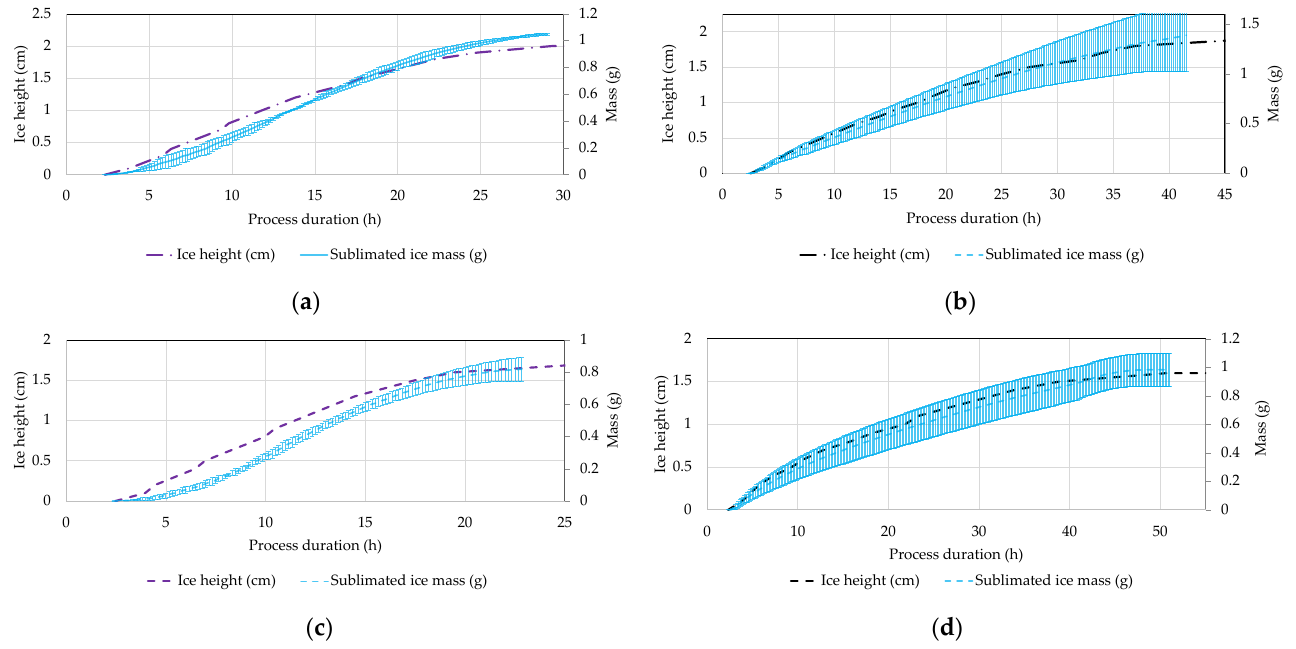
Figure 22. Sublimated mass and ice height ( a ) 5 g/L saccharose, ( b ) 100 g/L saccharose, ( c ) 5 g/L mannitol, ( d ) 100 g/L mannitol.